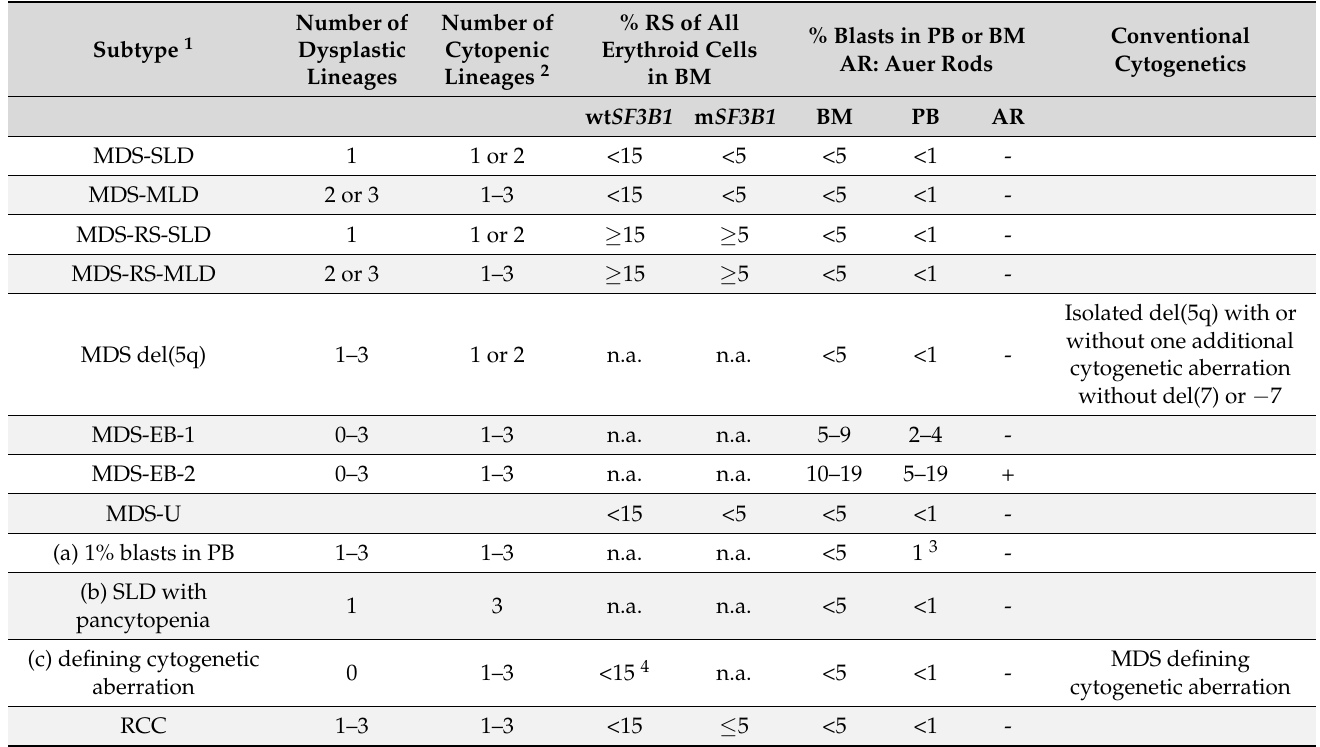
Table 4. WHO 2016 classification for MDS.